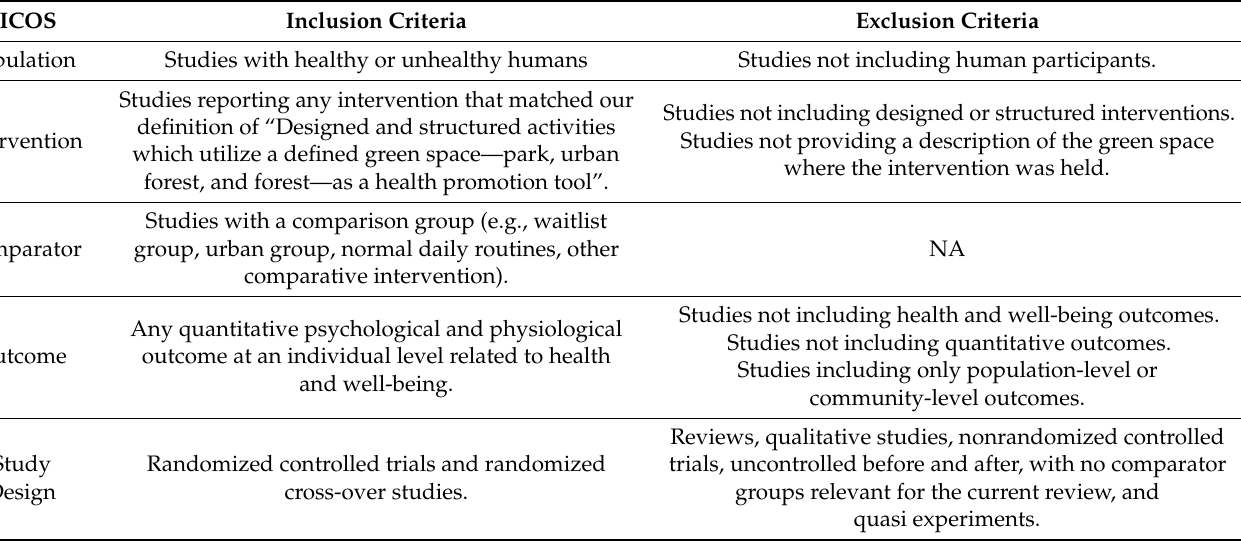
Table 1. Eligibility criteria for study